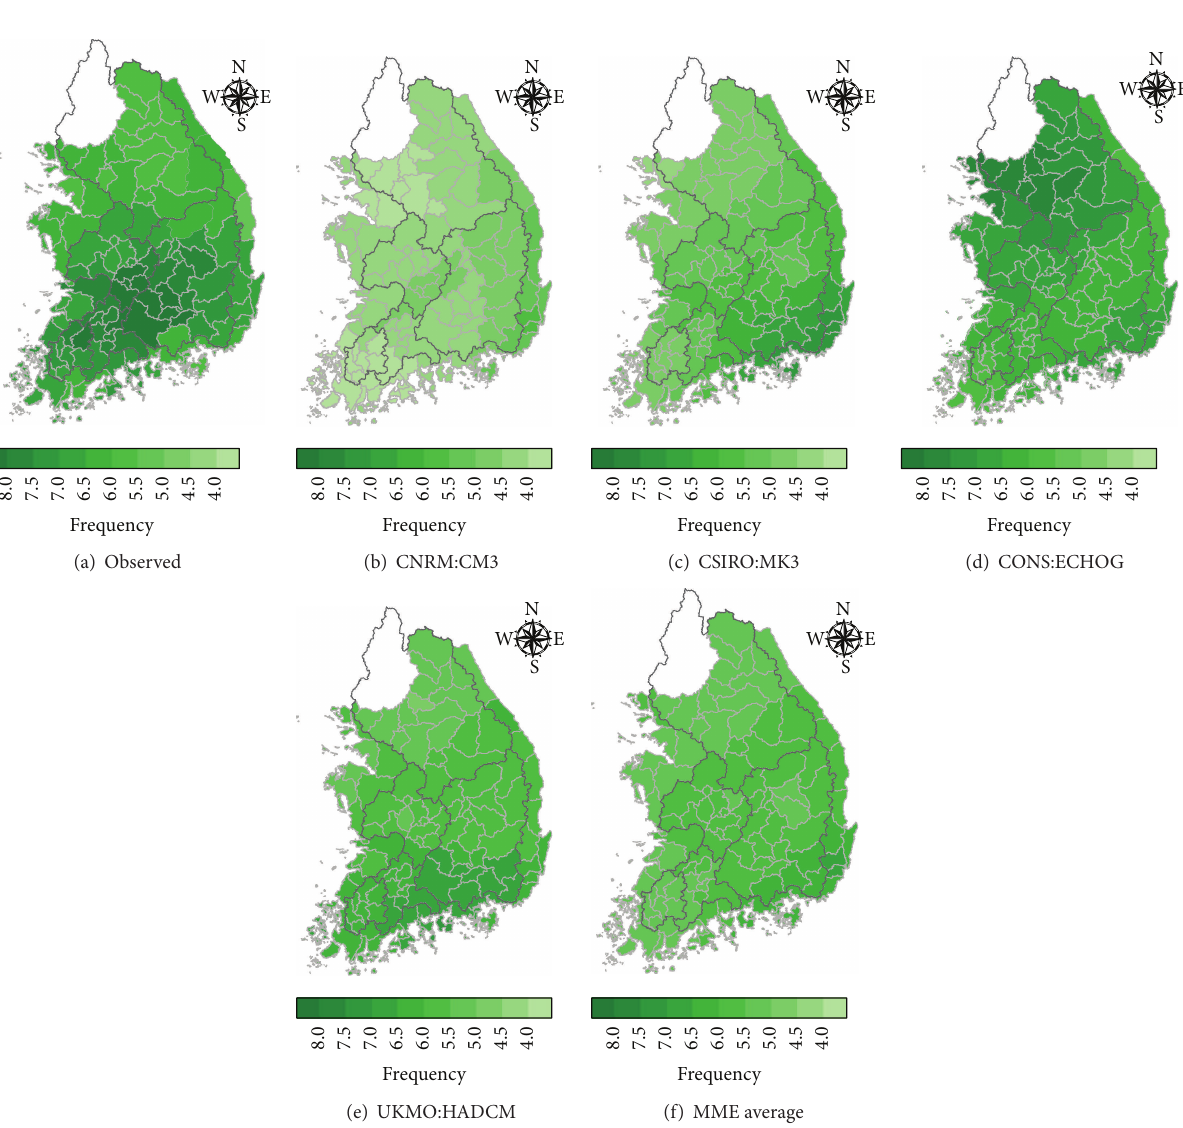
Figure 7: The spatial distribution of the frequency in severe dry stages with three-month SPI less than or equal to − 1.5 for past and future climate change projections. (a) Observed frequency of severe drought for the period 1976–2010 and (b–f) projected frequency of severe drought by each GCM and MME average for the period 2011–2099 for the climate change scenario. Note that the SPI series is calculated from a downscaled monthly precipitation using the four GCMs as